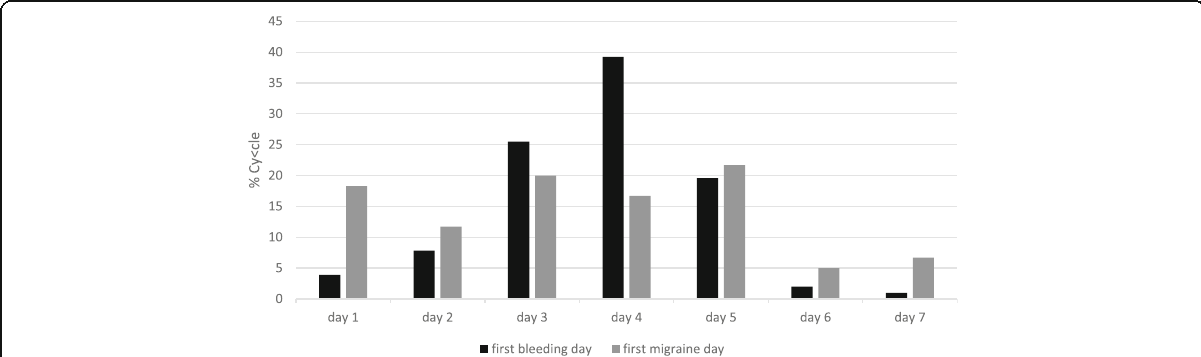
Fig. 1 First day of bleeding and first migraine day in the seven days of the hormone-free interval of combined hormonal contraceptive users